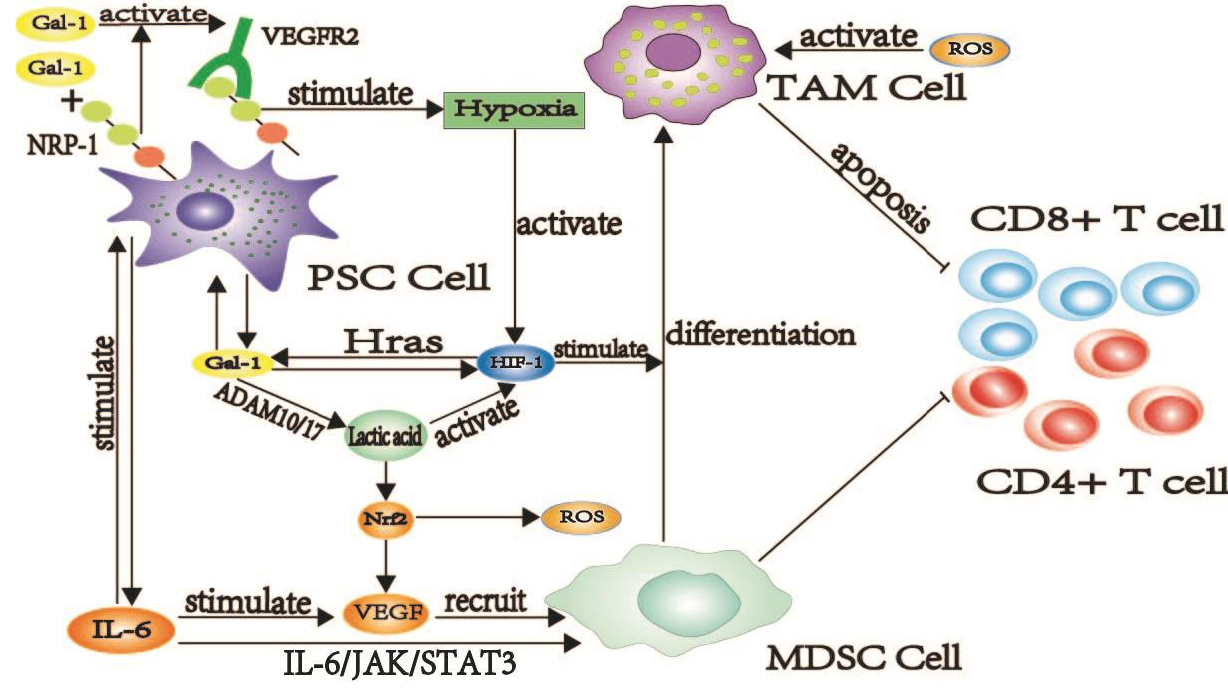
Figure 1. Pathway diagram of galectin-1 involved immunosuppressive signals of PDAC induced by TAM. TAM and MDSC cells prevented PDAC from being killed by T cells by promoting T cell apop- tosis and inducing T cell dysfunction. MDSC was a precursor of TAM, and galectin-1 was involved